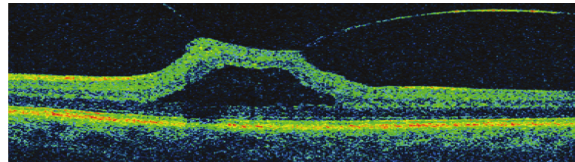
Figure 5: Vitreomacular